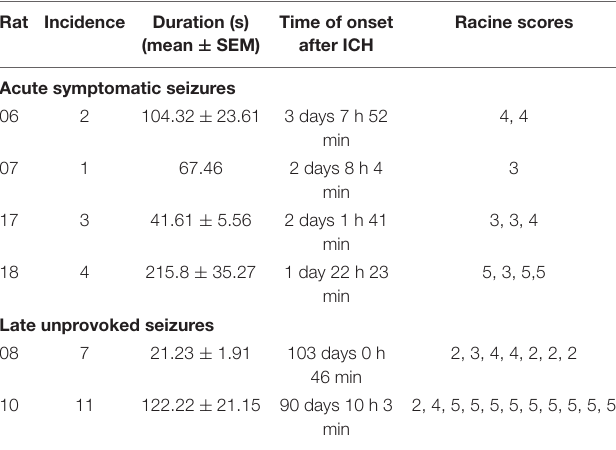
TABLE 1 | Characteristics of seizures are visualized. For each animal, the incidence, duration, seizure onset and Racine scores are given. Rat Incidence Duration (s) Time of onset Racine scores (mean ± SEM) after ICH